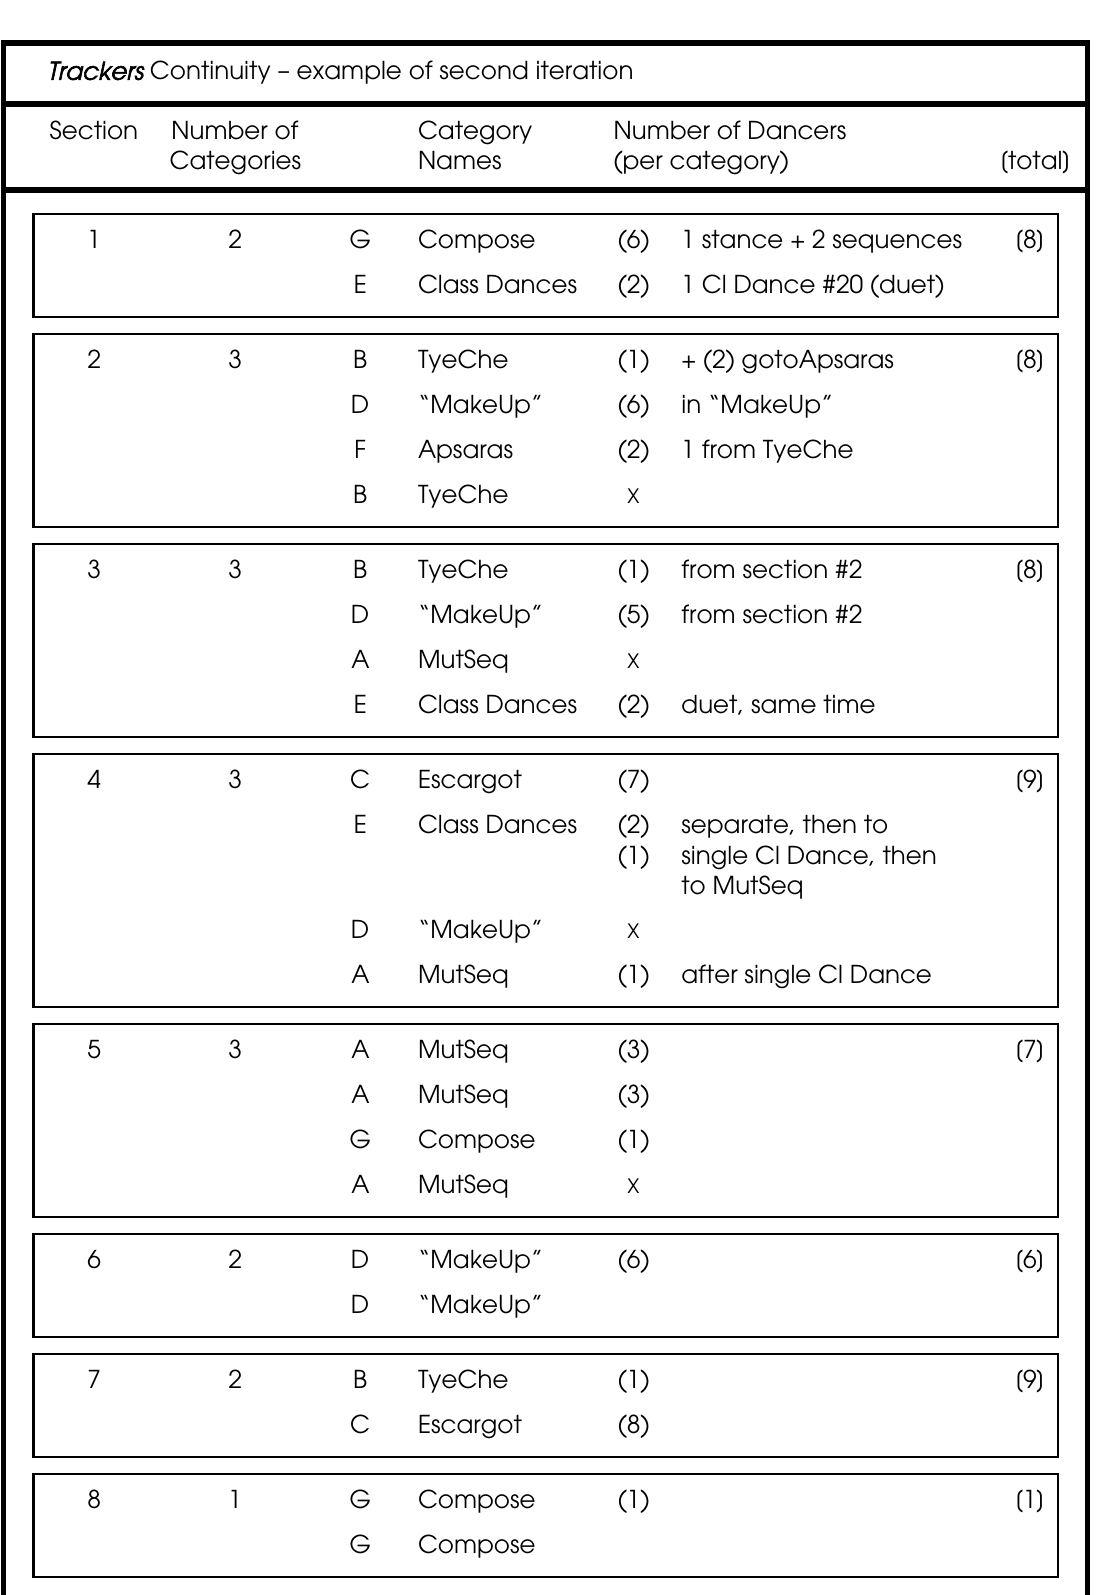
Figure 4.6 Trackers continuity, second